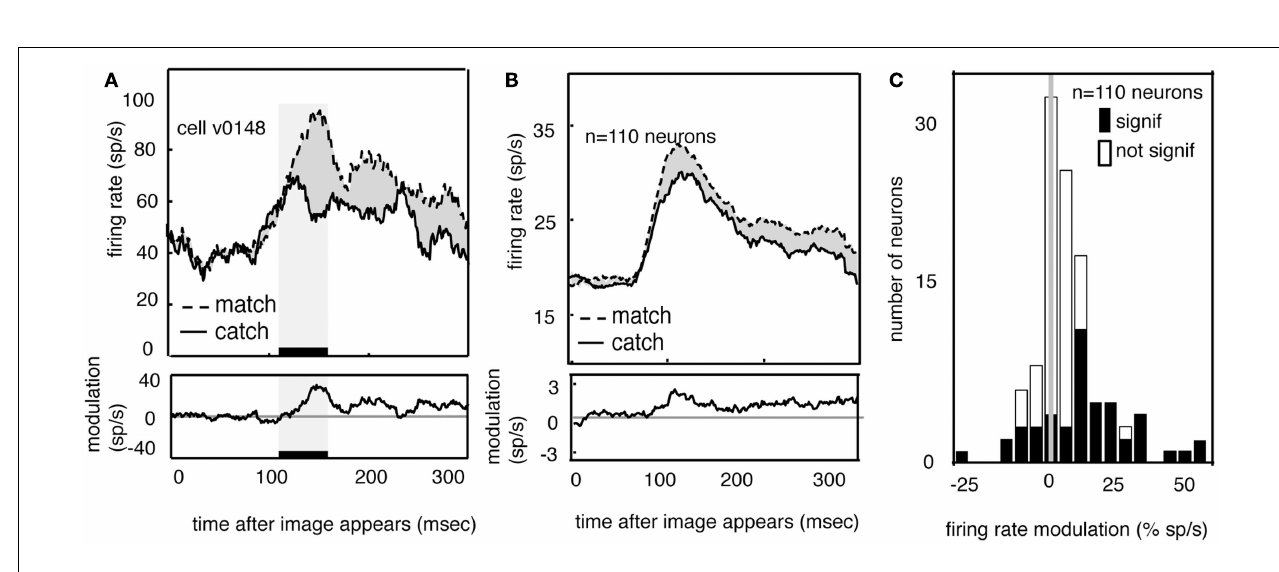
population, responses to the match are greater than responses to the feature catch.The size of this modulation is relatively consistent across the response. (C) Histogram of the size of match enhancement for all the neurons in our sample. Black bars denote significantly modulated neurons. Population is significantly skewed to the right ( p < 0.01), indicating that match enhancement is significantly more common than